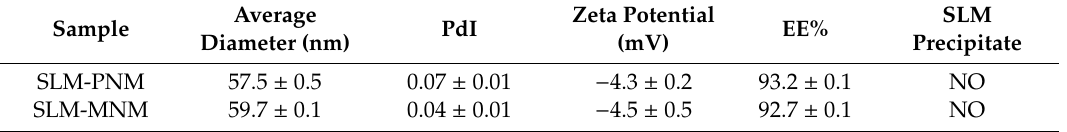
Table 3. Storage stability test of SLM-PNM and SLM-MNM at 4 ◦ C (Mean ± SD, n = 3). Sample